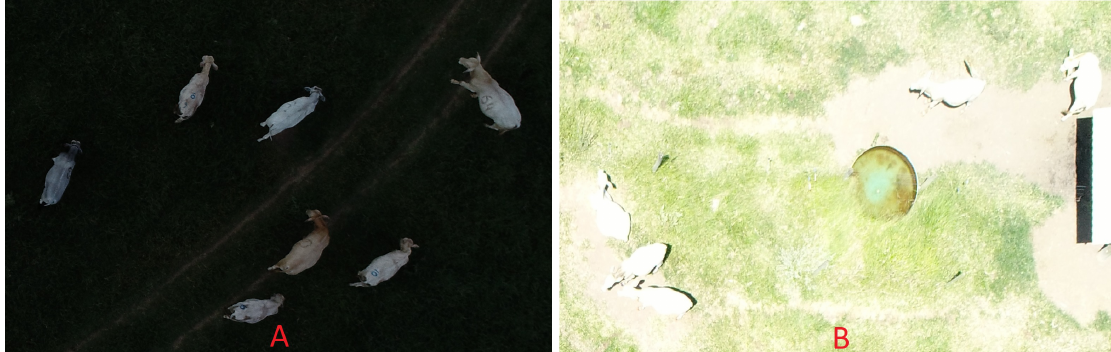
Figure 8. Examples of images with underexposure ( A ) and overexposure ( B